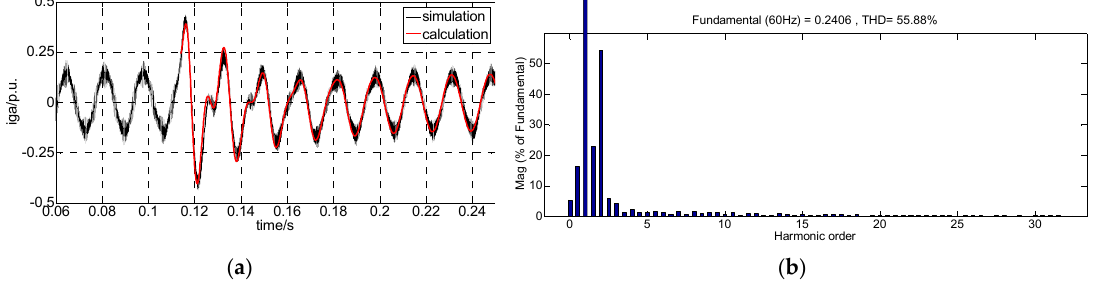
Figure 7. GSC short-circuit current and its frequency spectral analysis: ( a ) comparison between simulated and calculated waveform; ( b ) frequency spectral analysis.